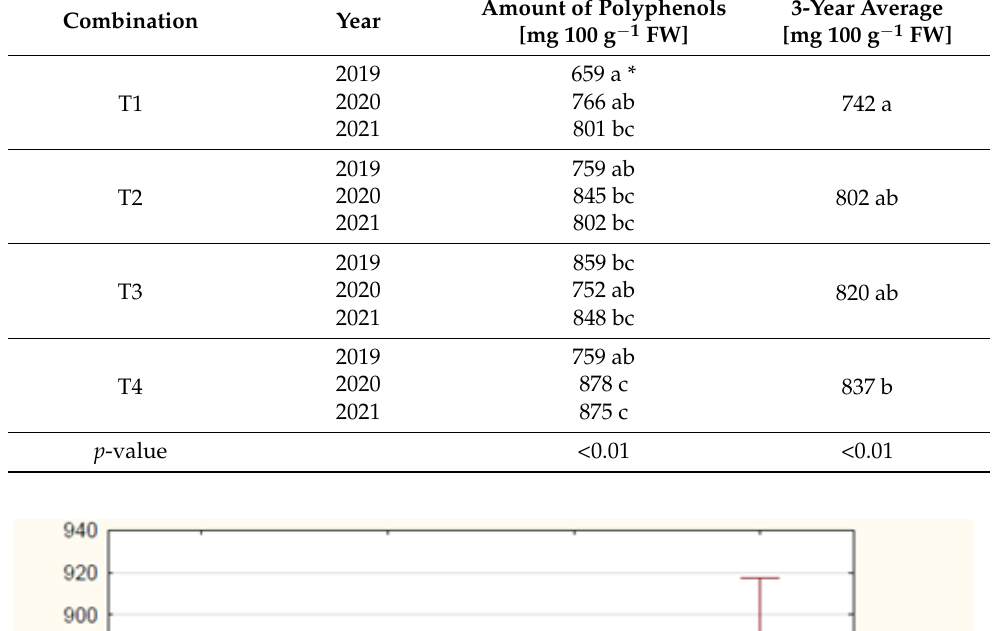
Table 5. Influence of fertilization technology on amount of polyphenols—data averaged over the years of the study. * Data followed by the same letter are not significantly different.